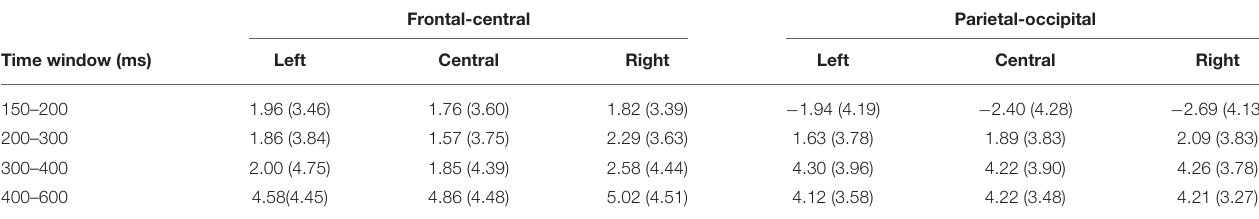
TABLE 1 | Average ERP amplitudes within each scalp area in each post-stimulus onset time window (standard deviations are in parentheses). Frontal-central